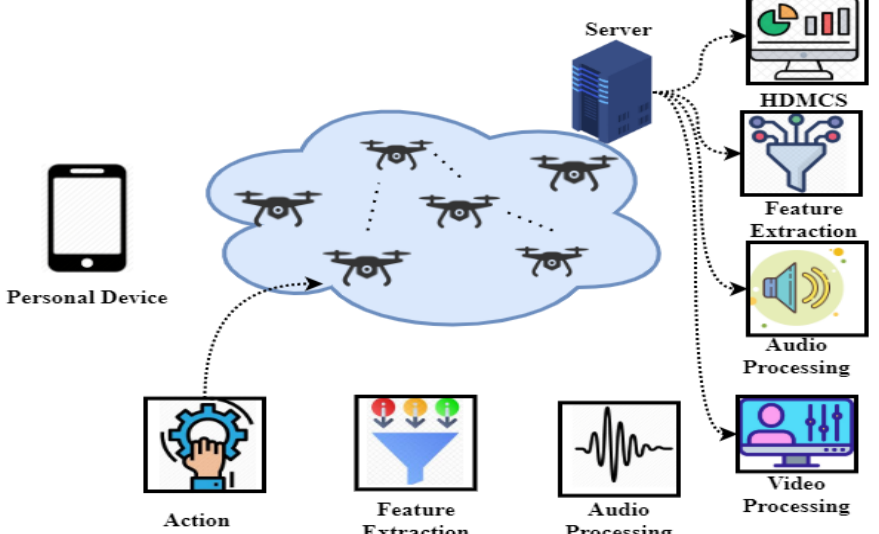
Figure 7. Proposed SOA-based disaster and crisis management system.